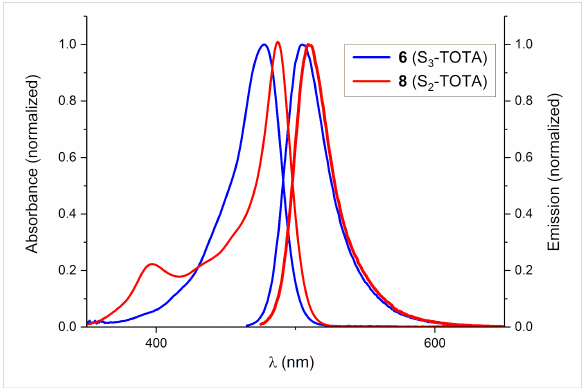
Figure 7: Normalized absorption and fluorescence spectra of 6 (S 3 - TOTA + ), λ ex = 460 nm, and 8 (S 2 -TOTA + ), λ ex = 470 nm, in CH 2 Cl 2